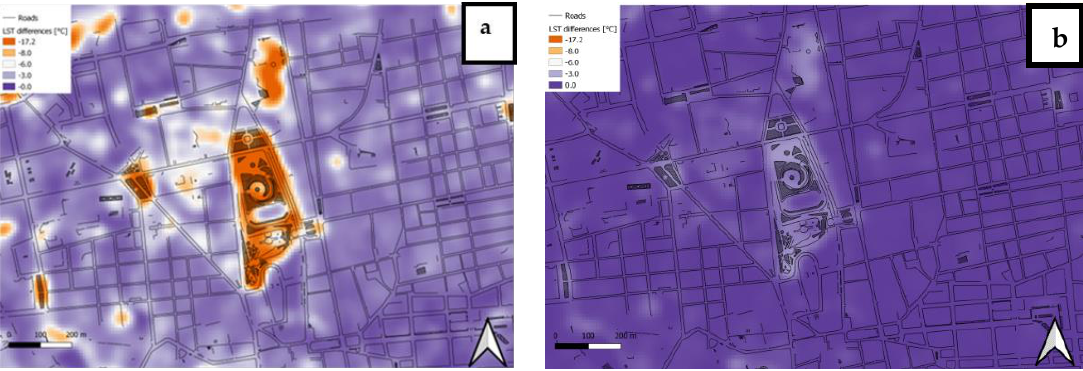
11 of 19 Figure 7. Daytime ( a ) and nighttime ( b ) LST 10 on 14 July 2017. Daytime ( c ) and nighttime ( d ) LST 10 on 26 August 2017.